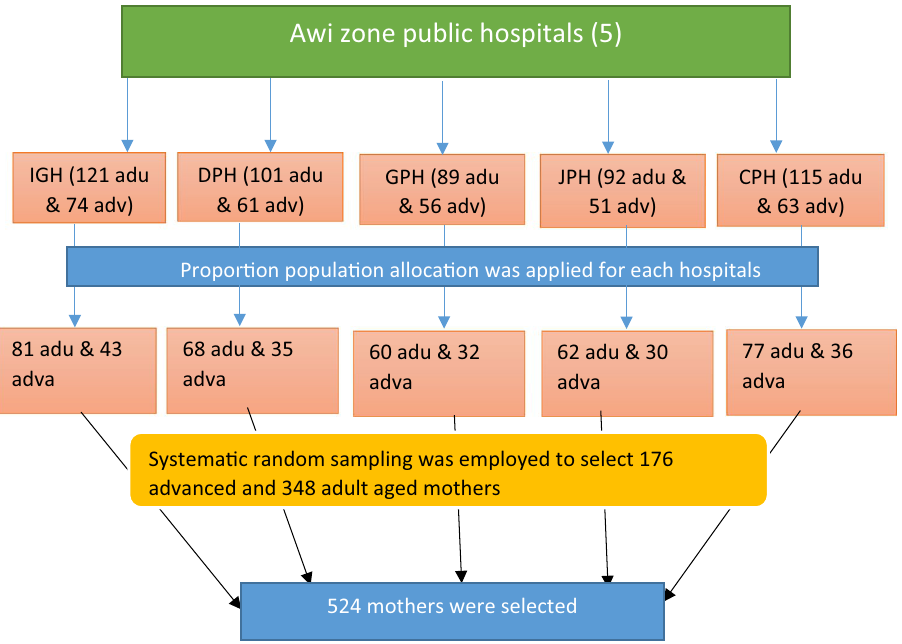
Figure 1. Schematic presentation of sampling procedure to select 524 women, at Awi Zone public hospitals, Ethiopia